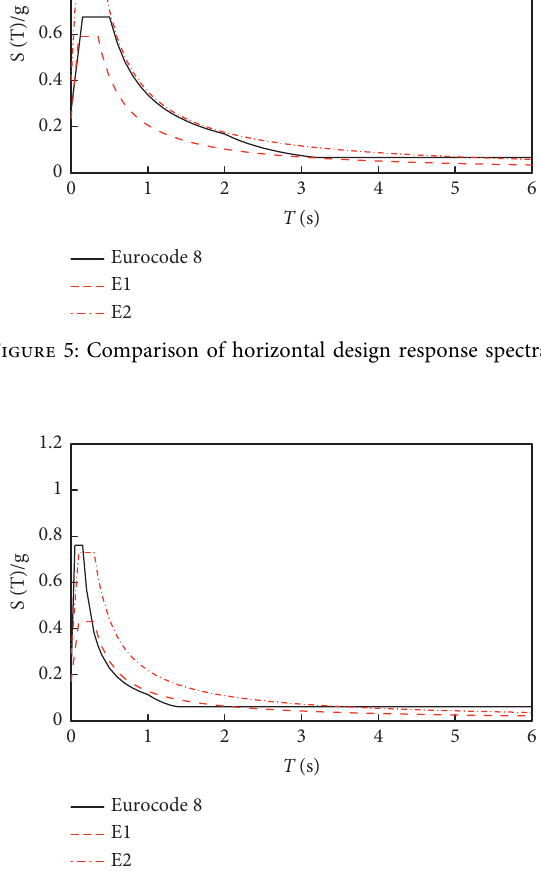
Figure 6: Comparison of vertical design response